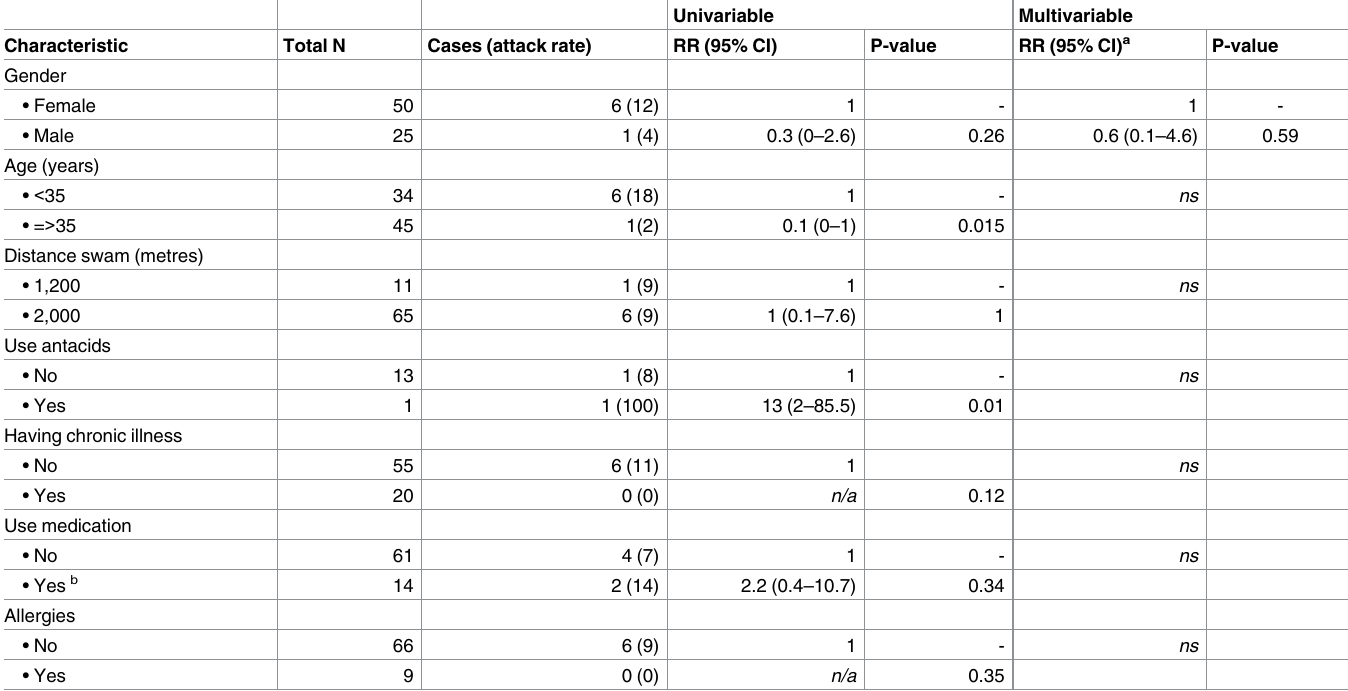
Table 2. Univariable and multivariable analysis on risk factors for AGI in the Singel Swim Utrecht among swimmers ( n = 79), 14 June